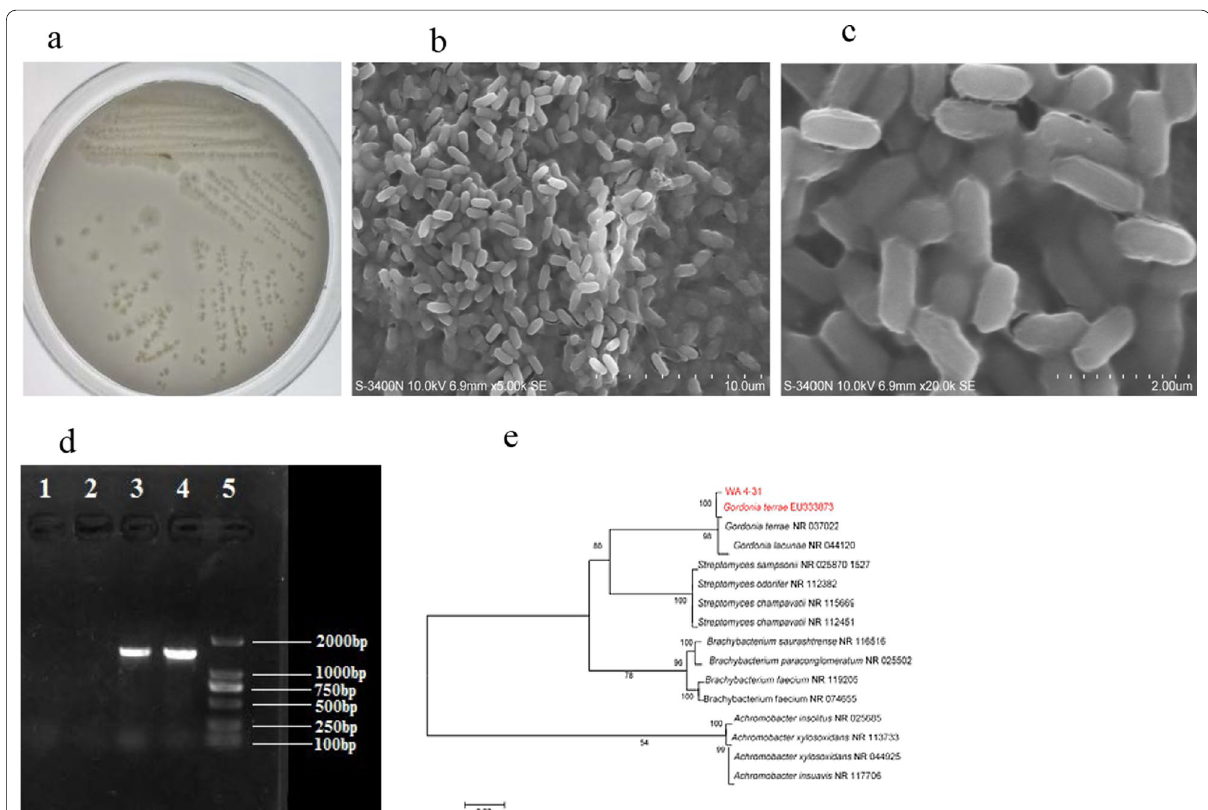
Fig. 1 Results of strain identification a Colonies of Strain WA4-31 on Gauze’s medium. b Observation Results of Strain WA4-31 under Scanning Electron Microscope of 5000 . c Observation Results of Strain WA4-31 under Scanning Electron Microscope of 20,000 × Products of 16S rDNA by Agarose Gel Electrophoresis. 1 、 2: Black control; 3 、 4:WA4-31 16S rDNA; 5:2000 DNA marker. e Phylogenetic Tree of Strain WA 4-31. Maximum-likelihood phylogenetic tree based on 16S rDNA gene sequences showing the positions of strain WA 4-31, the type strains of other Gordonia and representatives of some other related taxa. Only bootstrap values (expressed as percentages of 1,000 replications) greater than 50% are shown at branching points. Bar, 0.02 substitutions per nucleotide position